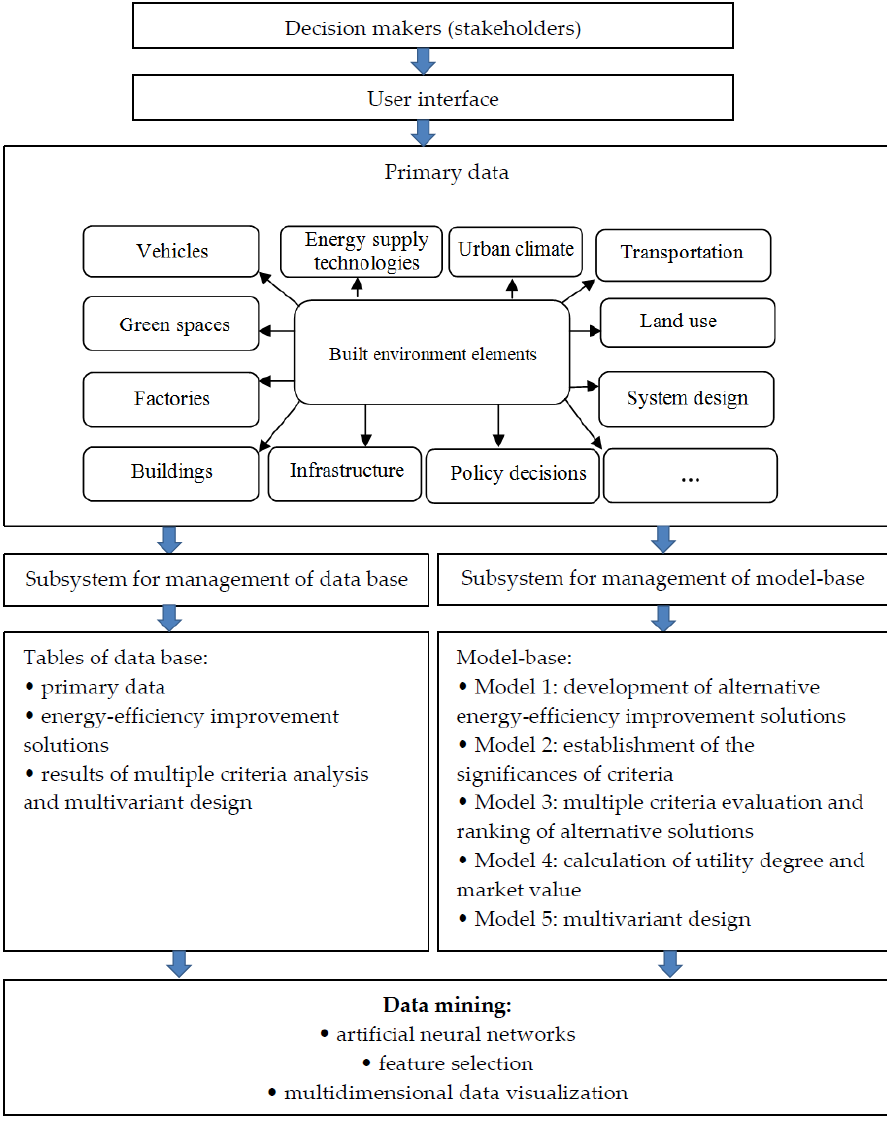
Figure 2. Structure of the NANSEN.